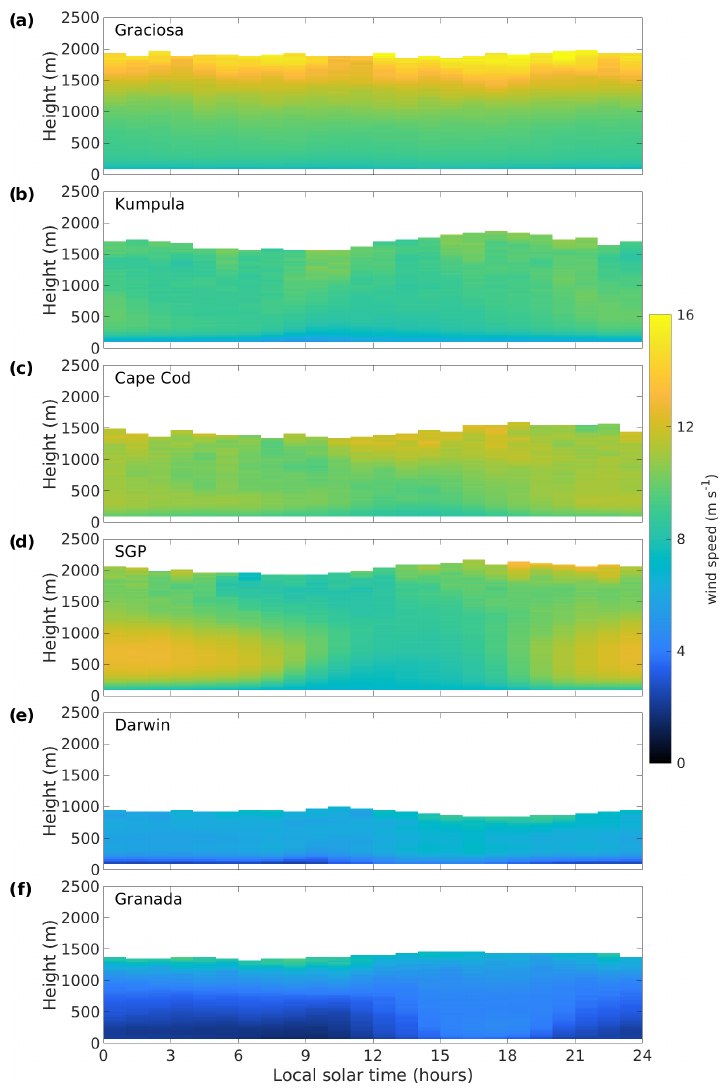
Figure A3. Diurnal composites of mean wind speed measured by the Doppler lidar at (a) Graciosa, (b) Kumpula, (c) Cape Cod, (d) SGP, (e) Darwin, and (f) Granada. Time refers to approximate local solar